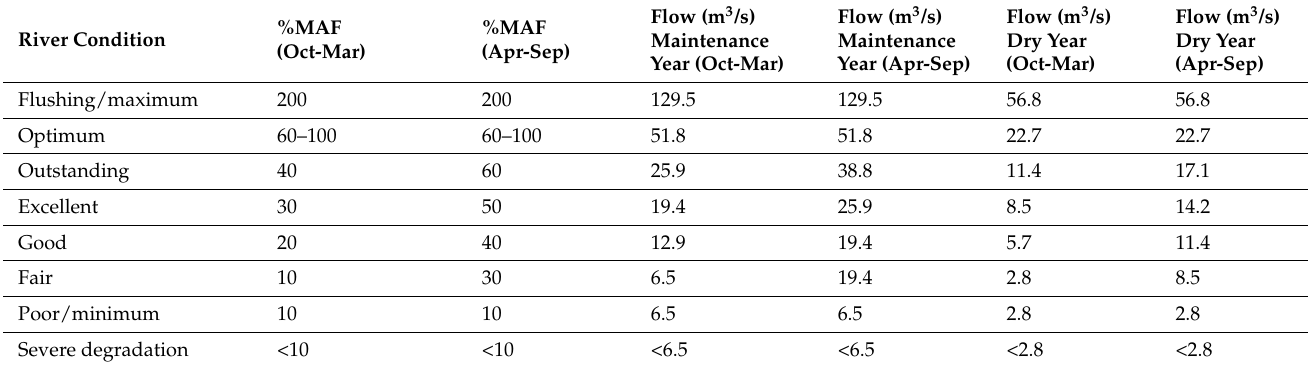
Table 7. Montana or Tennant Method—Percentage of Mean Annual Flow (%MAF) recommended for different river conditions in two seasons and the corresponding Environmental Flows for maintenance and dry years at Gama Gate. MAF: Mean Annual